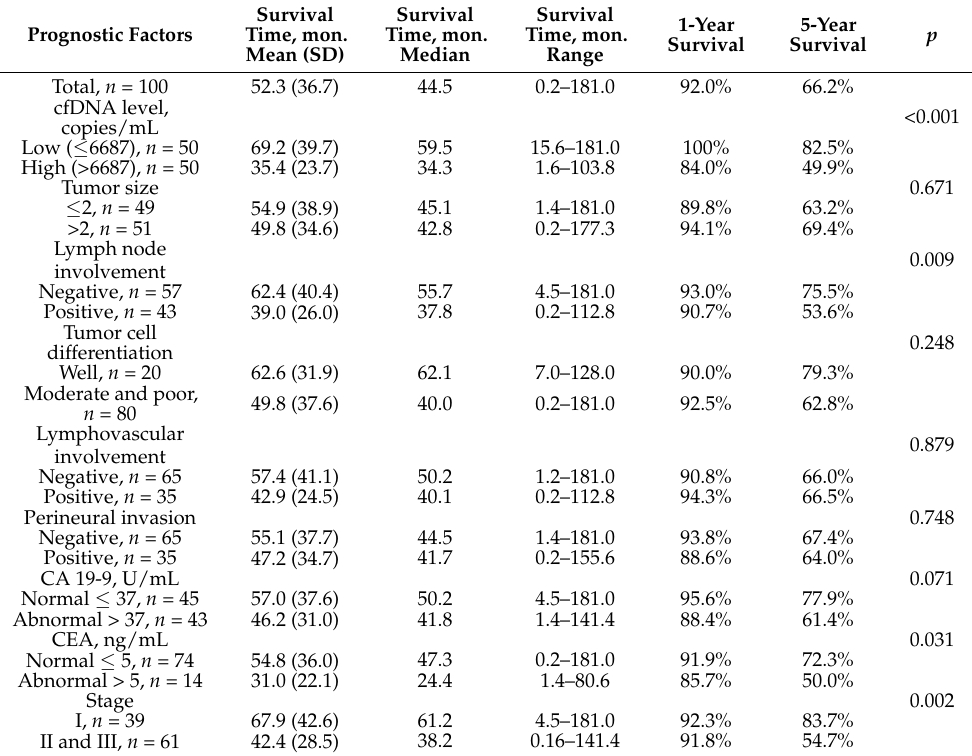
Table 2. Prognostic factors by univariate analysis for ampullary cancer patients undergoing pancre-